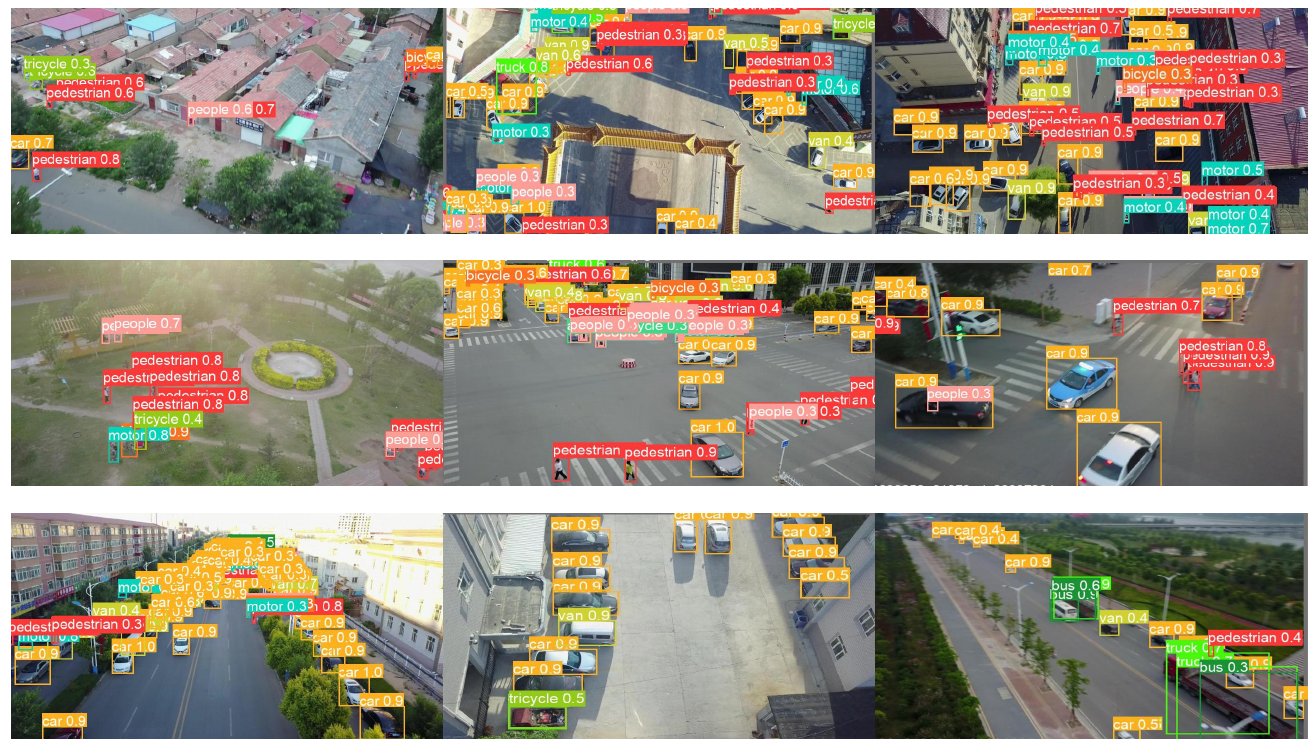
Figure 8. Visualization of some of the output of our suggested architecture on some of the test images of the VisDrone 2021